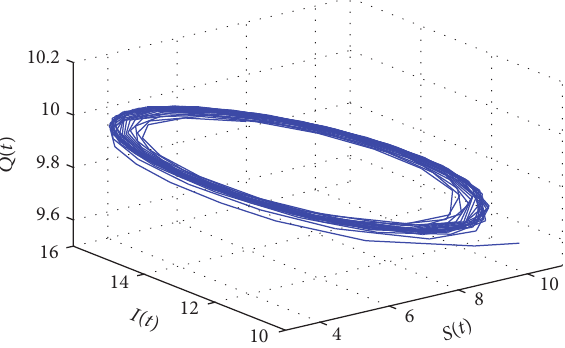
Figure 5: The phase plot of 𝑆 , 𝐼 , and 𝑄 when 𝜏 1 = 1.3625 > 1.3265 = 𝜏 10 .